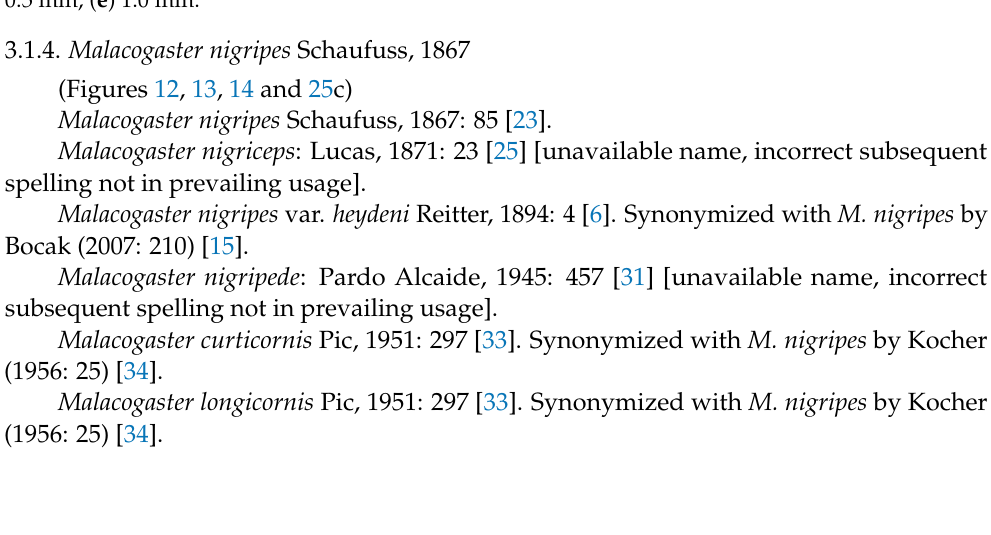
Figure 10. Malacogaster maculiventris Reitter, 1894. Male holotype of Malacogaster olcesei var. reductus Pic, 1949, syn. nov. ( a ) Habitus, dorsal view; ( b ) habitus, lateral view; ( c ) habitus, ventral view; ( d ) head, frontal view; ( e ) pronotum, dorsal view; ( f ) genital capsule formed by tergites IX and X, and sternite IX, dorsal view; ( g ) genital capsule formed by tergites IX and X, and sternite IX, lateral view; ( h ) genital capsule formed by tergites IX and X, and sternite IX, ventral view; ( i ) aedeagus, dorsal view; ( j ) aedeagus, lateral view; ( k ) aedeagus, ventral view. Scale bars = ( a – c ) 2.0 mm; ( d , f – k ) 0.5 mm; ( e ) 1.0 mm.